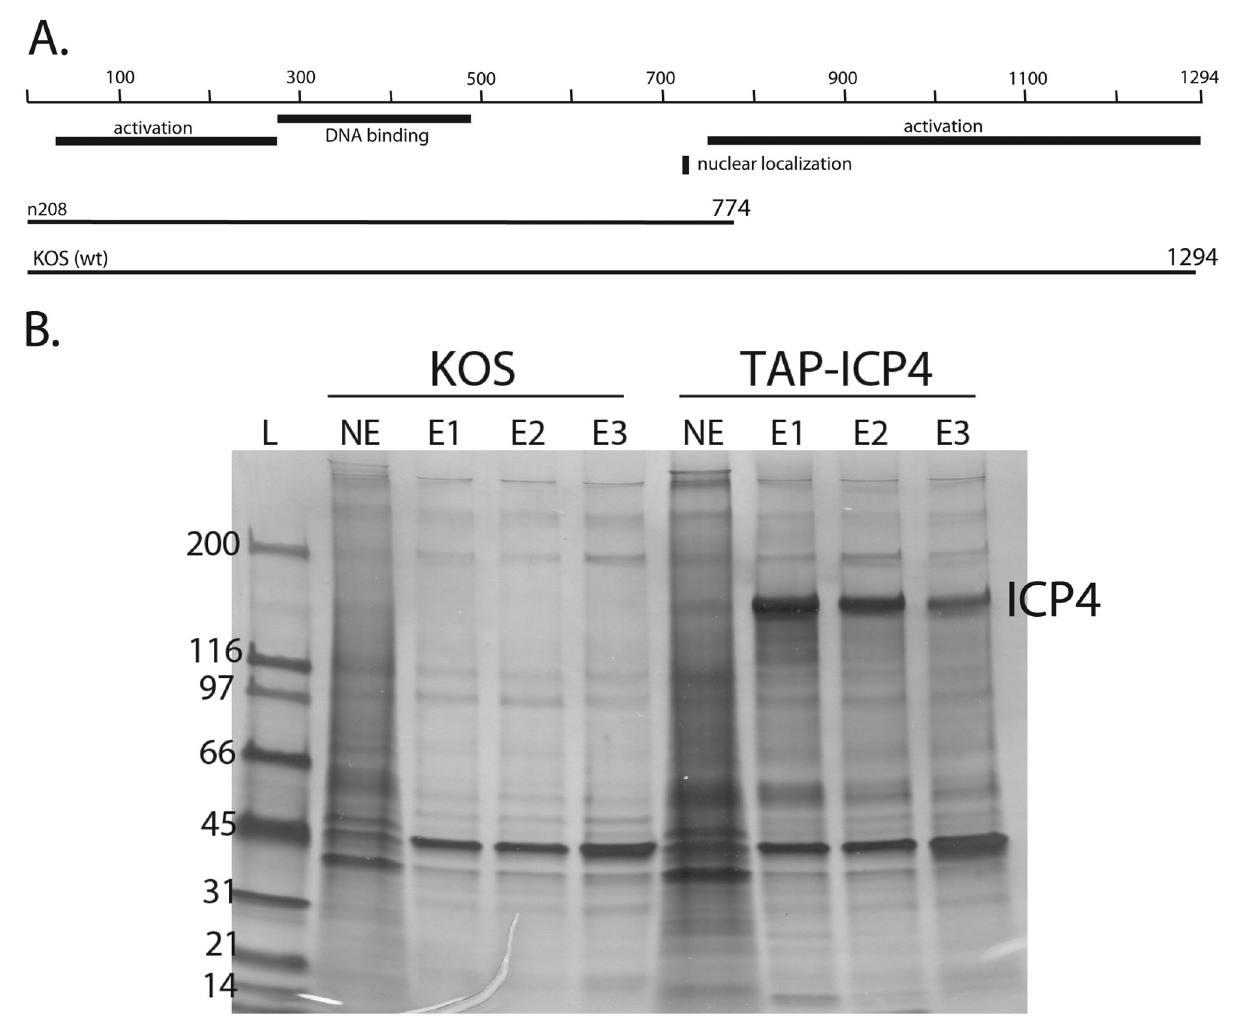
Figure 1. ICP4 molecules used in this study. ( A ) An affinity purification tag (TAP) was appended to amino acid 1 of the 1294 and 774 amino acid wild-type (wt) KOS and n208 molecules in the HSV genome. Also shown are regions involved in DNA binding, transactivation and nuclear localization. ( B ) Silver stain analysis of TAP-wtICP4 containing complexes. Samples were purified at 6 hpi using either wtICP4 (KOS) or TAP-wtICP4 (TAP-ICP4) expressing viruses. Nuclear extracts (NE) were loaded onto a streptavidin column and the affinity purified ICP4 was eluted from the streptavidin beads in three separate elutions (E1, E2, and E3). The resulting proteins were separated via SDS-PAGE and visualized by silver stain. Molecular weight standards are shown to the left